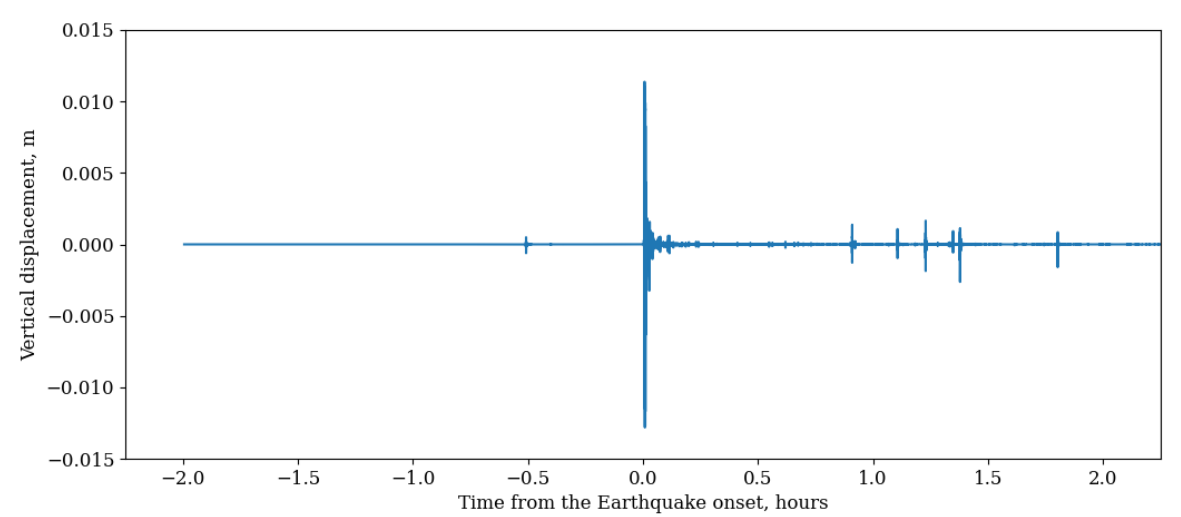
Figure A2. Ground displacement from the seismometer.